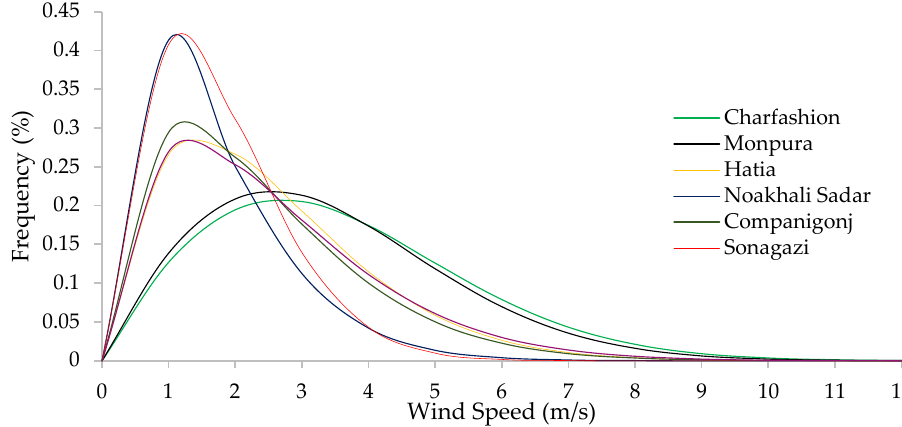
Figure 3. The Weibull probability distribution for the selected coastal sites at 10 m AGL.